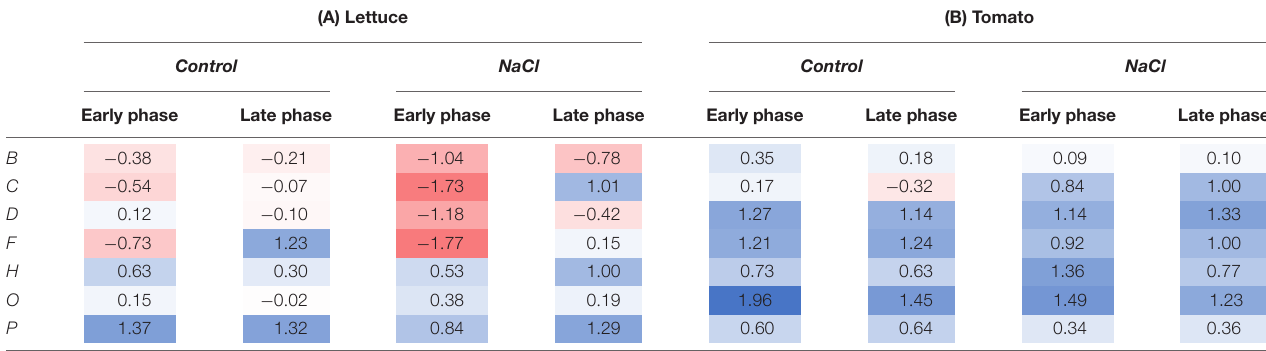
TABLE 1 | Classification of 7 protein hydrolysates (PHs) using Plant Biostimulant Characterisation (PBC) index.